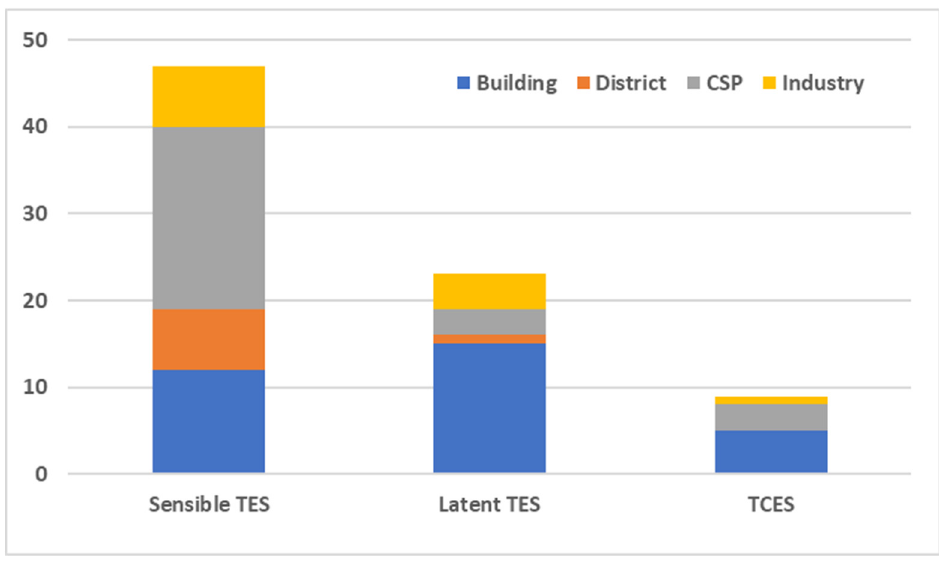
Figure 4. Number of publications on LCA of TES.